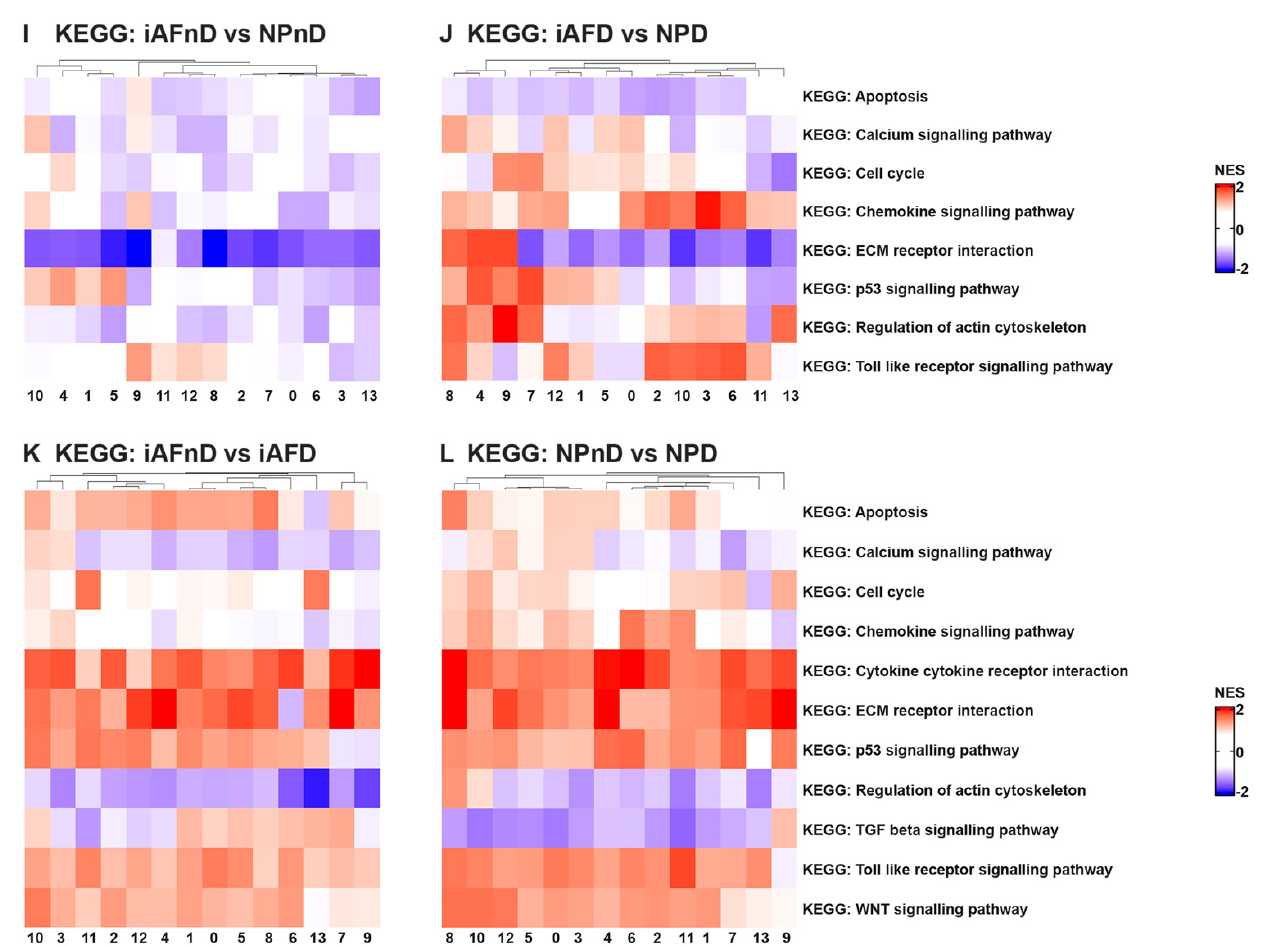
Figure 5. GO term and KEGG analysis of DEGs between NP and iAF cells from nD and D IVDs. Heatmap representations depicting the differences in affected biological processes ( A – D ), molecular functions ( E – H ) and KEGG ( I – L ) pathways per cluster (0–13) in iAFnD vs. NPnD ( A , E , I ), iAFD vs. NPD ( B , F , J ), iAFnD vs. iAFD ( C , G , K ) and NPnD vs. NPD ( D , H , L ) cell populations. Upregulated genes in each cluster were used for the analysis. Complete GO terms and KEGG lists are shown in the supplemental Tables S14–S22.